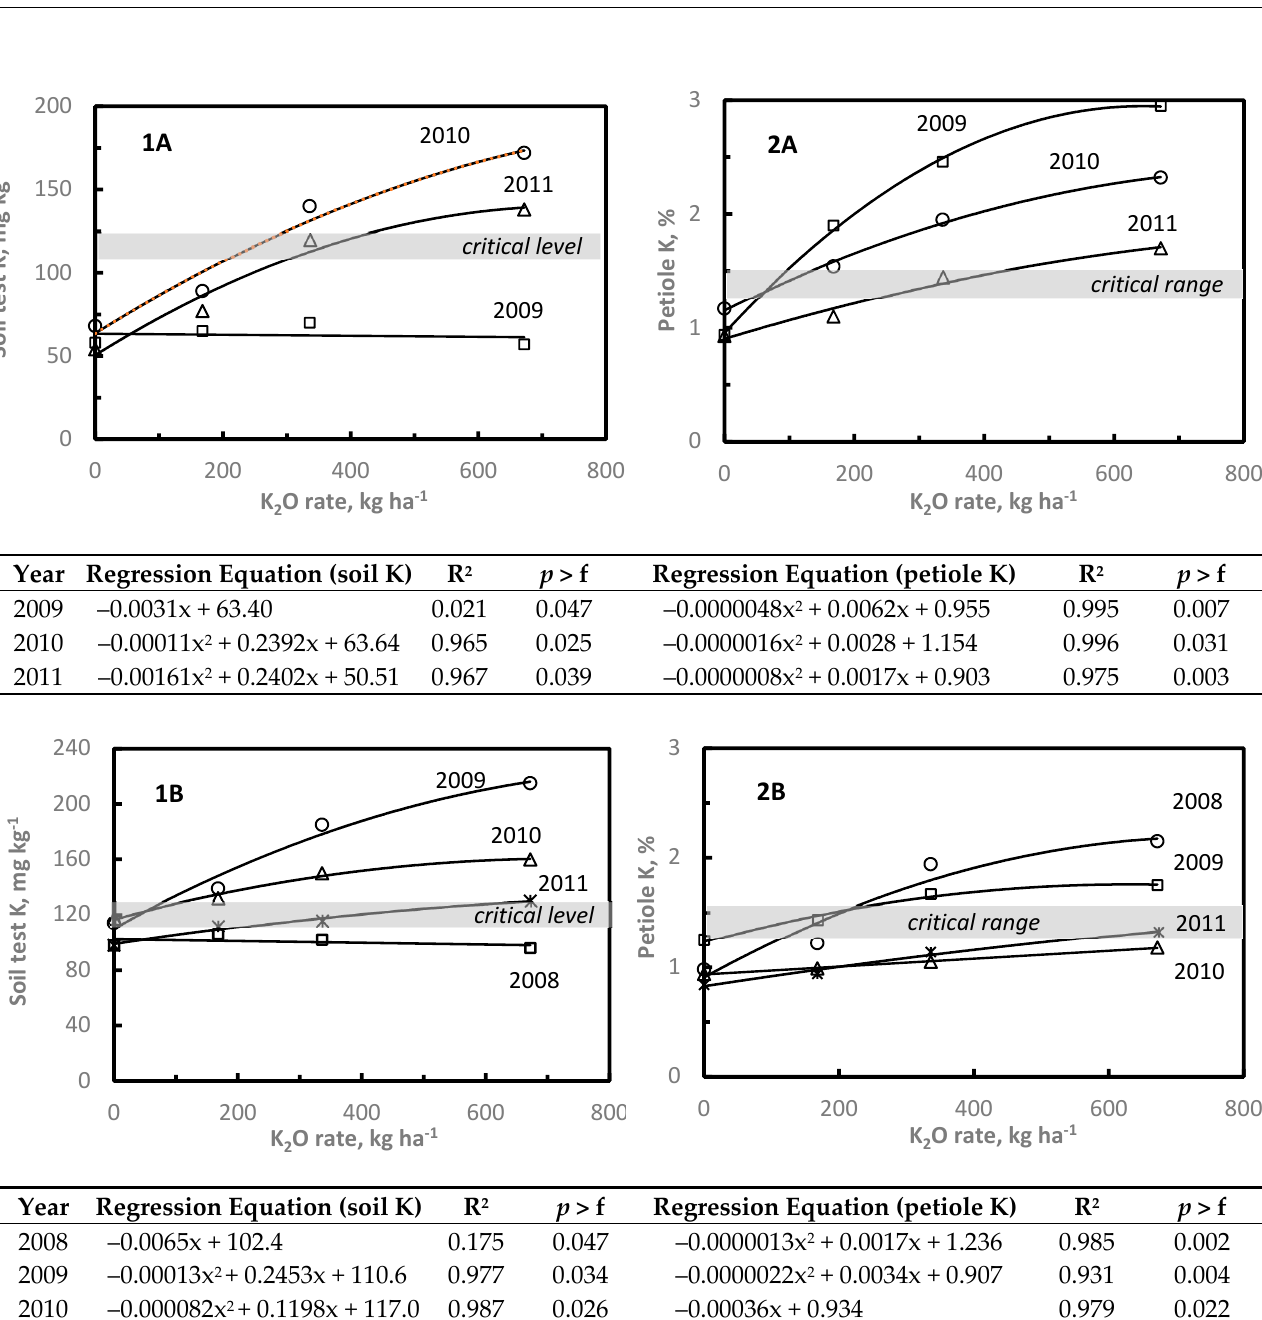
Figure 3. Influence of soil applied K 2 O on soil test K (1) and petiole K (2) content at 1K09 (A) and 2K08 (B) sites. Critical soil test level and critical nutrient range are displayed (shaded bar). Symbols for each year represent treatment means.